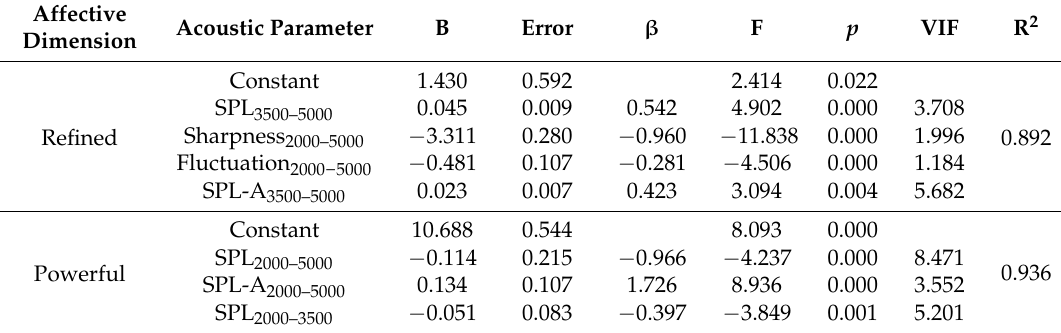
Table 10. Results of regression analysis of affective dimensions for all acoustic parameters.